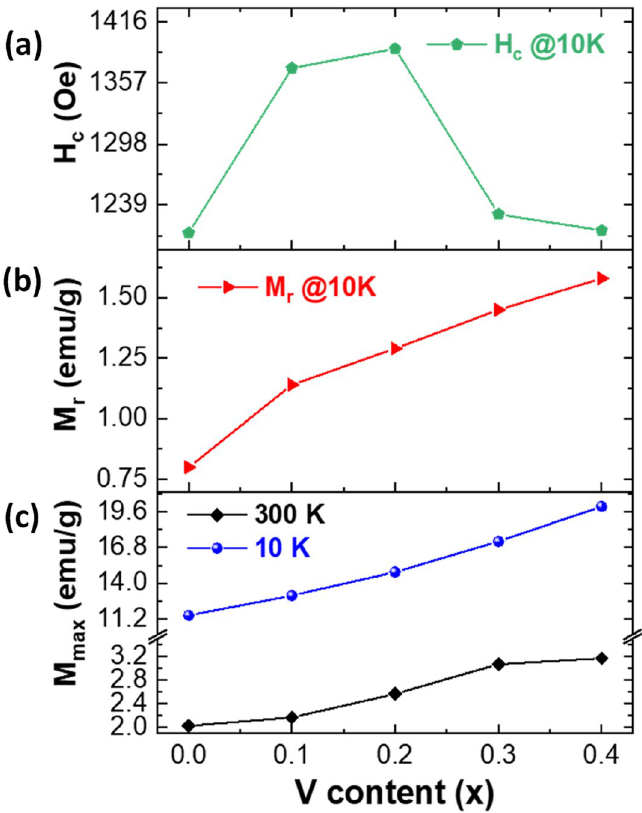
Figure 7. Evolutions in (a) M max (± 70 kOe) at 300 and 10 K, (b) M r at 10 K, and (c) H c at 10 K concerning